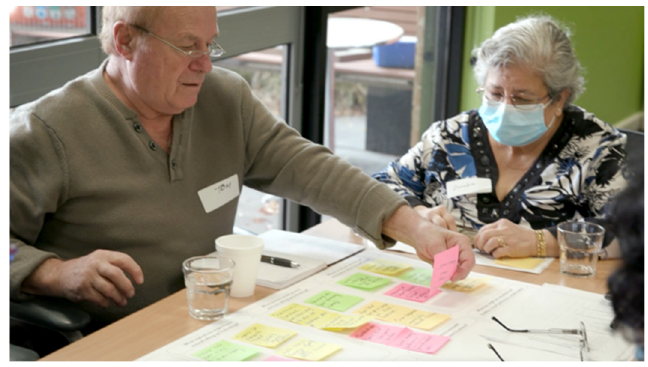
Figure 9. Older adults participating in scenario personarrative activities.